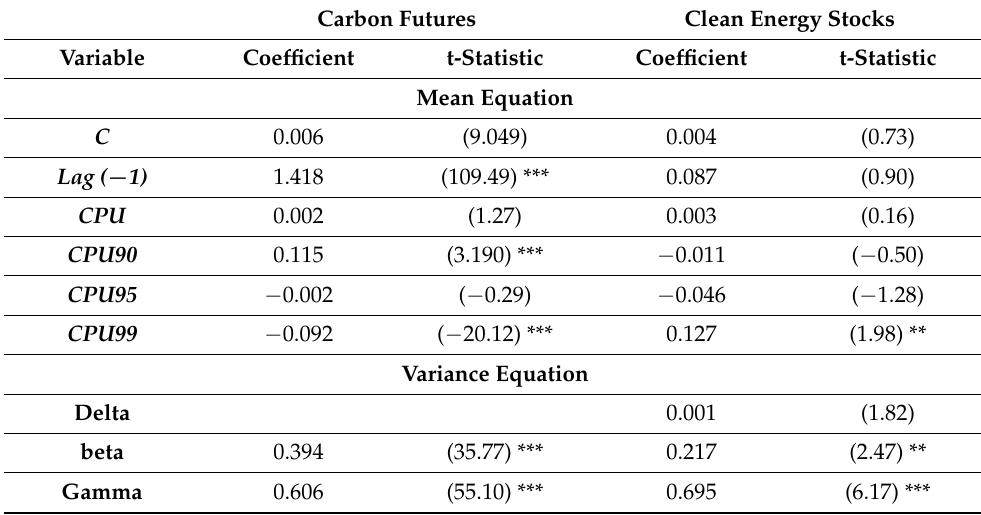
Table 2. GARCH (1,1) with